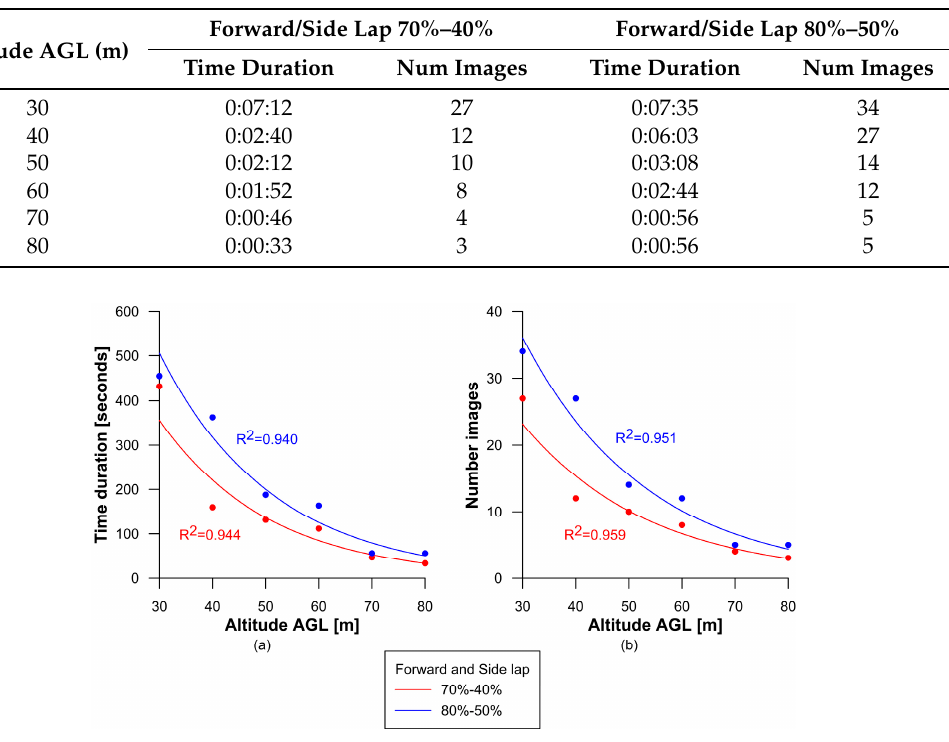
Table 2. Flight durations and the number of images taken at different altitudes Above Ground Level (AGL) and forward and side lap settings.